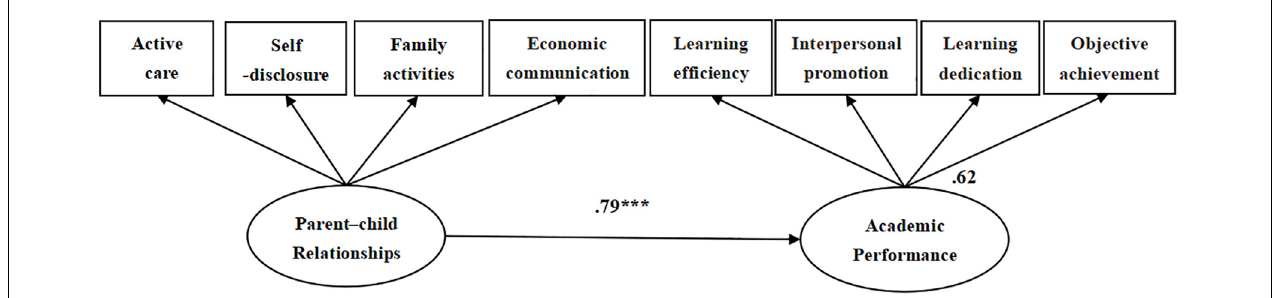
FIGURE 2 | Main effects of parent–child relationships on the academic performance. *** p < 0.001.